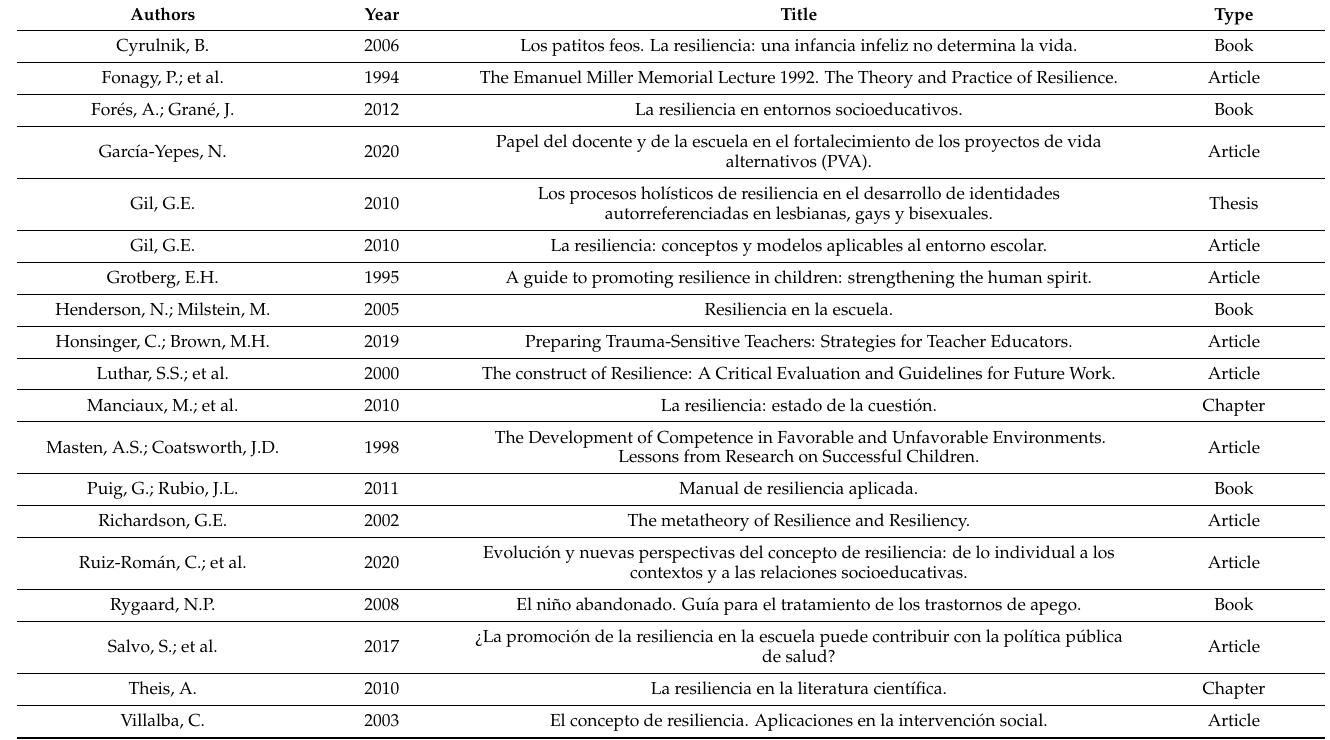
Table 3. Characteristics of the selected